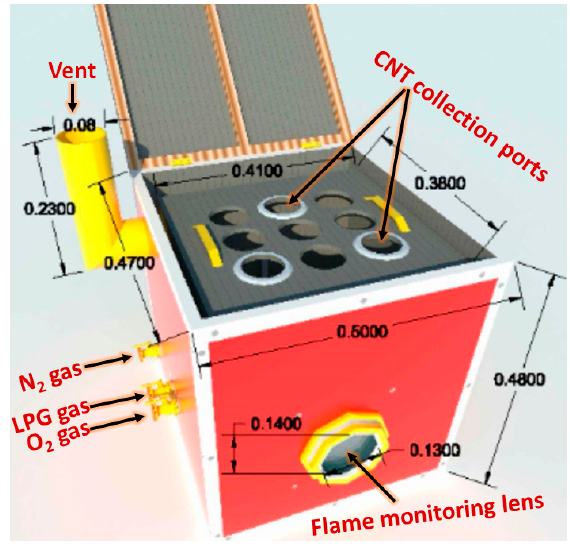
Figure 1. The homemade flame fragments deposition (FFD) instrument.